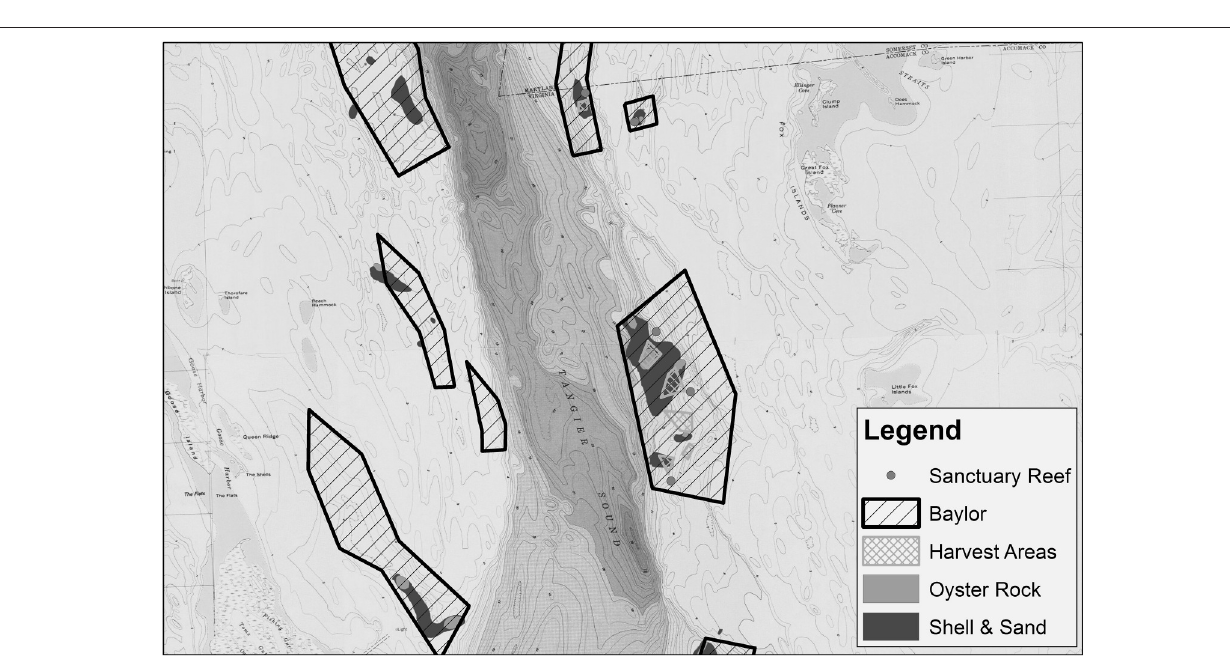
Extent of Oyster Habitat and Loss Over